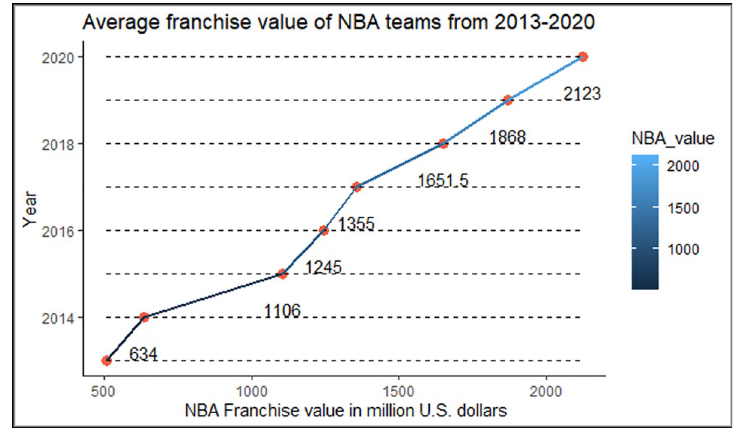
Fig 1. Average franchise value of NBA teams from